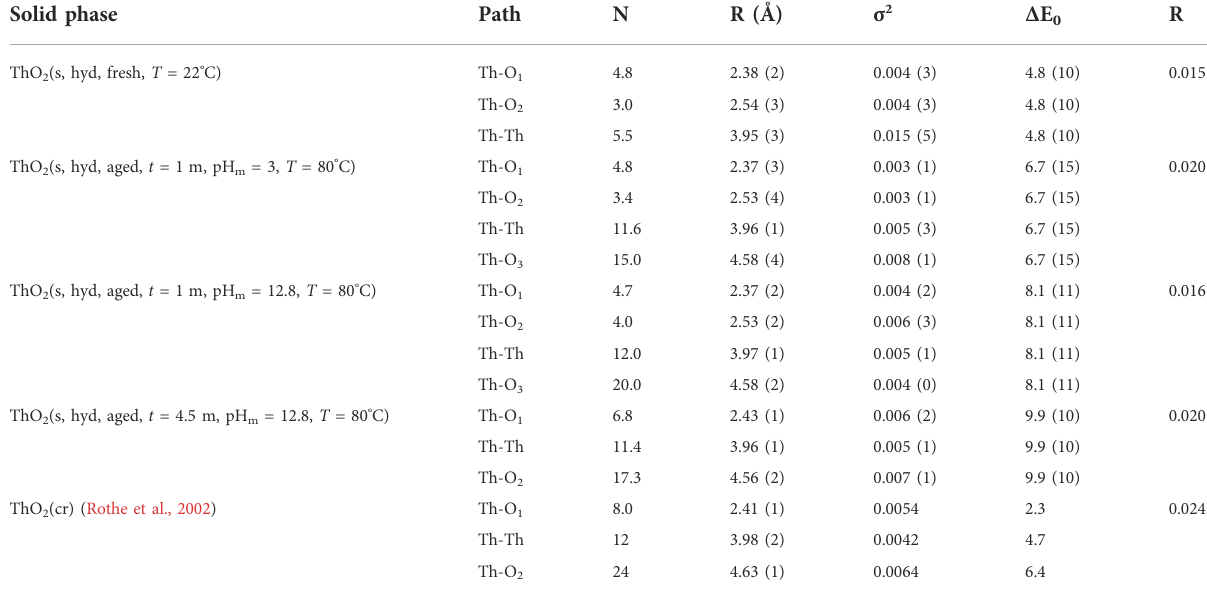
TABLE 4 EXAFS fi t data for select solid samples. Solid